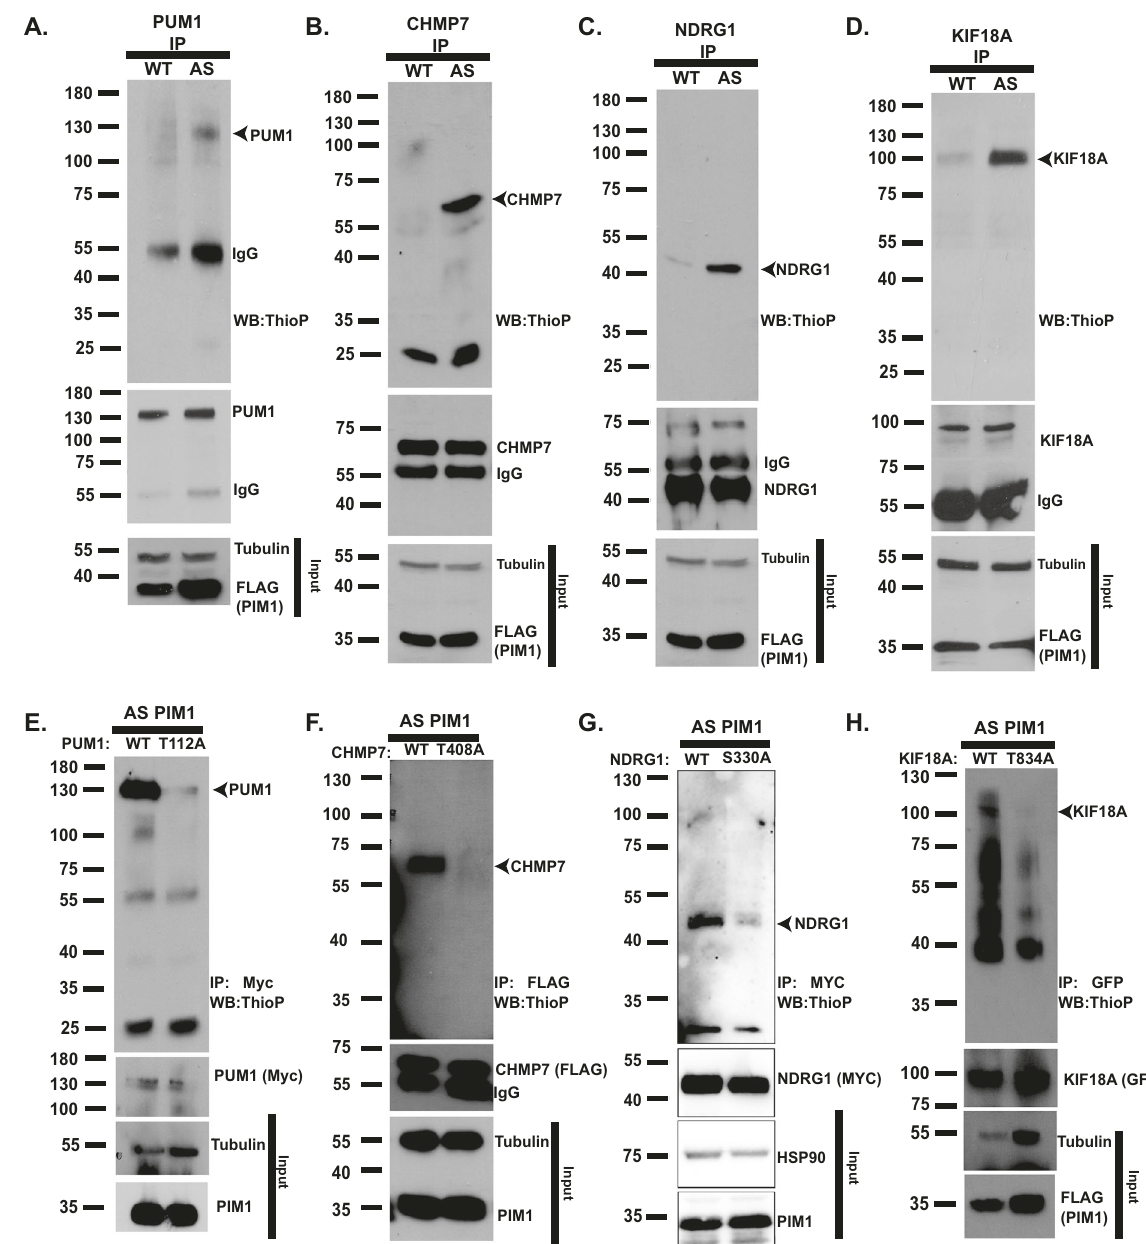
Fig. 3 AS PIM1 directly phosphorylates endogenous high-con fi dence substrates in prostate cancer cells. A – D Validation of endogenous PIM1 substrates. LNCaP-AS PIM1 thiophosphorylates PUM1 A , CHMP7 B , NDRG1 C , and KIF18A D . Endogenous proteins were immunoprecipitated from LNCaP-WT PIM1 and LNCaP-AS PIM1 and analyzed by western blot for the presence of thiophosphorylation (ThioP), or immunoprecipitated PUM1, CHMP7, NDRG1, and KIF18A. E – H Phosphorylation site validation using WT and phosphorylation site mutant substrates. Substrates (Myc-PUM1, FLAG-CHMP7, FLAG-NDRG1, and GFP-6HIS-KIF18A; either wild-type (WT) or the indicated PIM1 phosphorylation site mutation) were expressed in 293 T cells with AS PIM1 and thiophosphorylation labeling completed. Substrates were immunoprecipitated using Myc, FLAG, or GFP-magnetic beads, and Western blot performed to detect thiophosphorylated, or the immunoprecipitated substrates. Western blots are representative of two independent